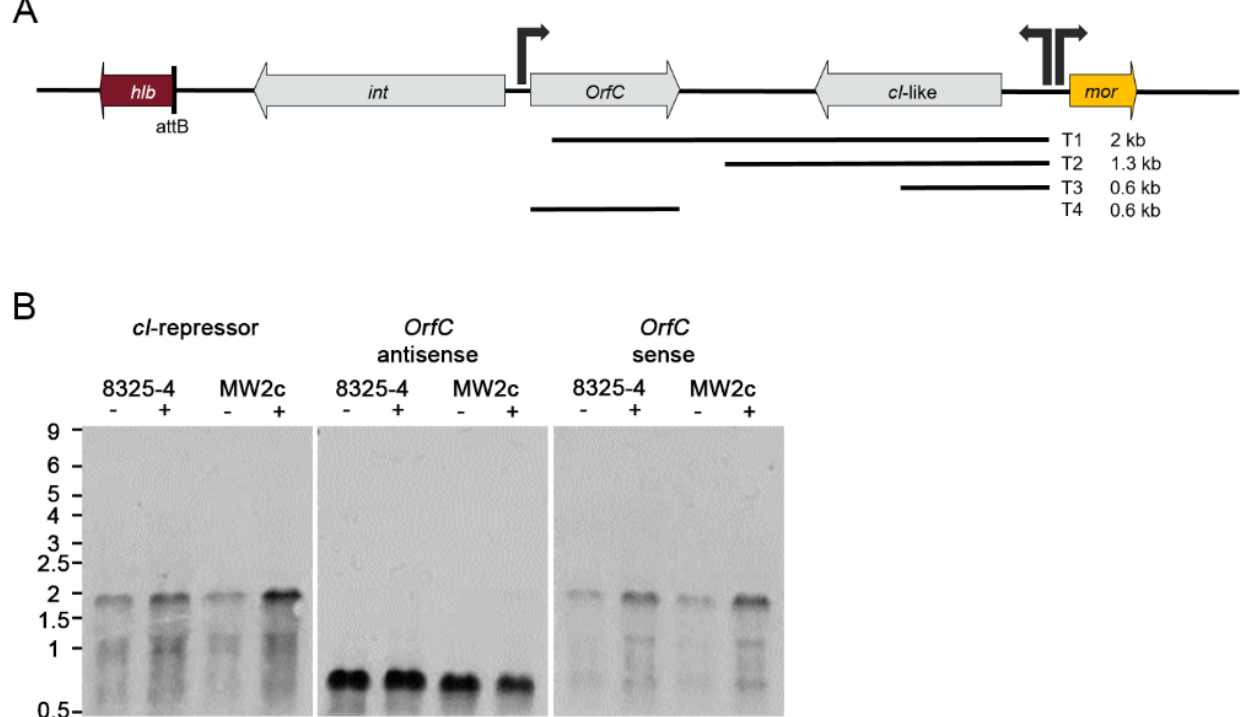
Figure 5. Transcriptional organization of the lysogenic modules of Φ 13. Schematic representation of the lyosegenic module ( A ) of Φ 13. Transcriptional units were visualized by hybridization of total RNA with digoxigenin-labeled RNA probes ( B ). Replication-deficient derivatives ( ∆ rep) of 8325-4 Φ 13kan and MW2c Φ 13kan were grown to OD 600 = 0.7 and treated with (+) or without (-) mitomycin (1 h).